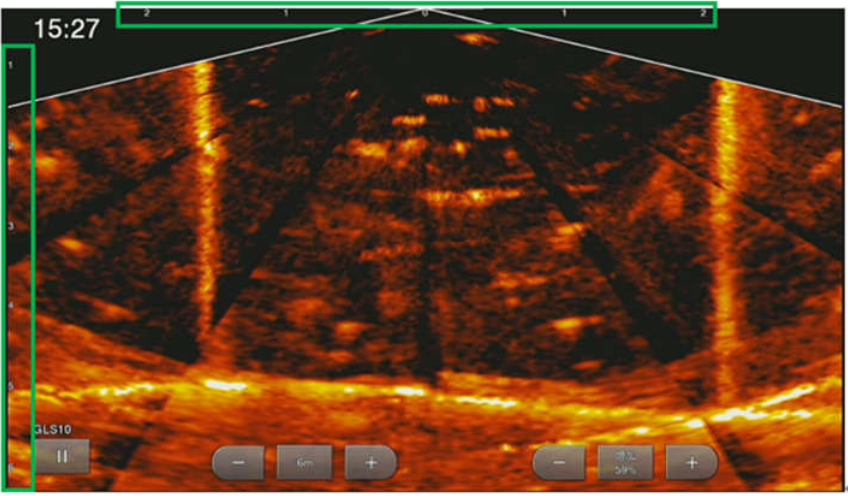
Figure 9. An example of the 1080 × 1092 sonar images captured from a 630 cm × 600 cm fish